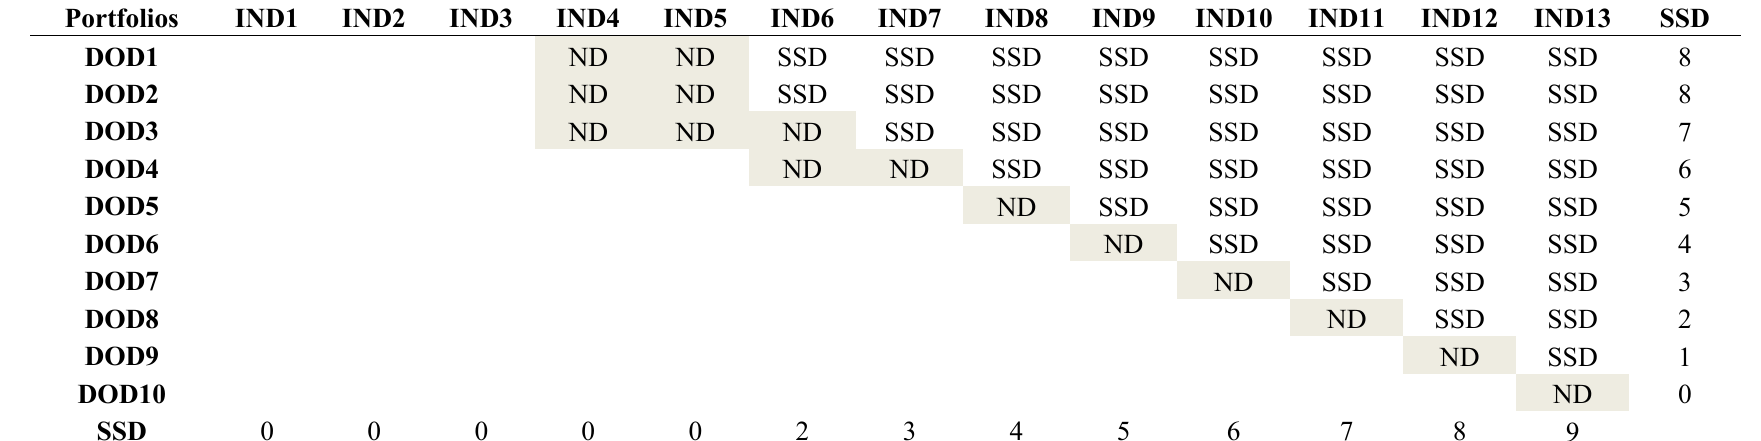
Table 4. Stochastic dominance test between domestically and internationally diversified